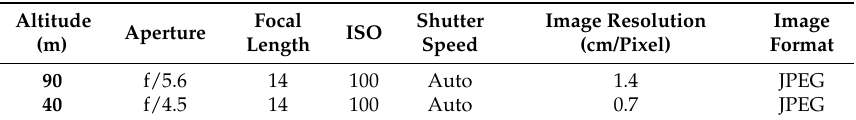
Figure 2. Orthomosaic of the 2014 field, displaying the location of Ground Control Points (GCP), LiDAR scan targets, the UAV flight path and the 10 experimental plots measured for this study. Coordinates are displayed in WGS 1984 Coordinate System. Table 3. Camera settings and image parameters used for the two data collection flights made during